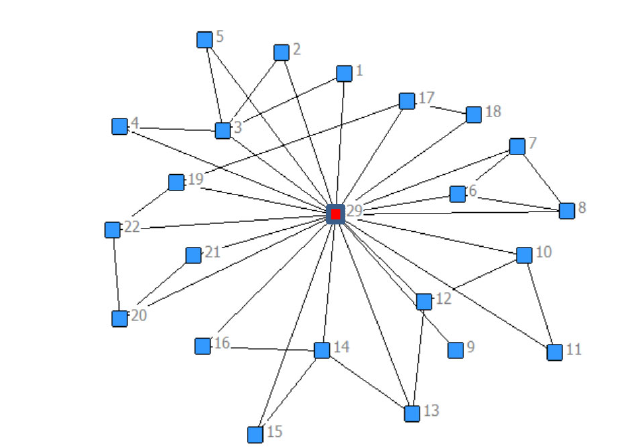
Figure 3. The network without six hardcore